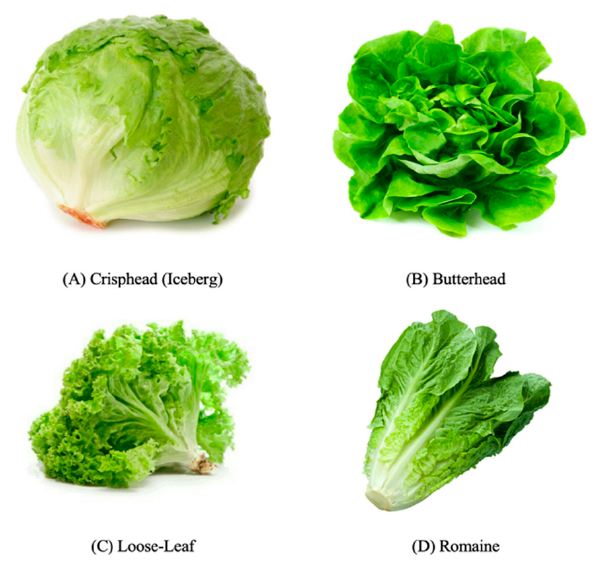
Figure 2. The frequent growth types of lettuce: Crisphead, Butterhead, Looseleaf, and Romaine.